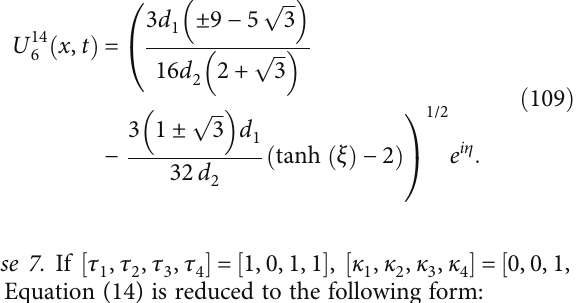
Figure 10: The graphical simulation representation of j U 11 δ = 0 : 6, w = 0 : 01 4 2